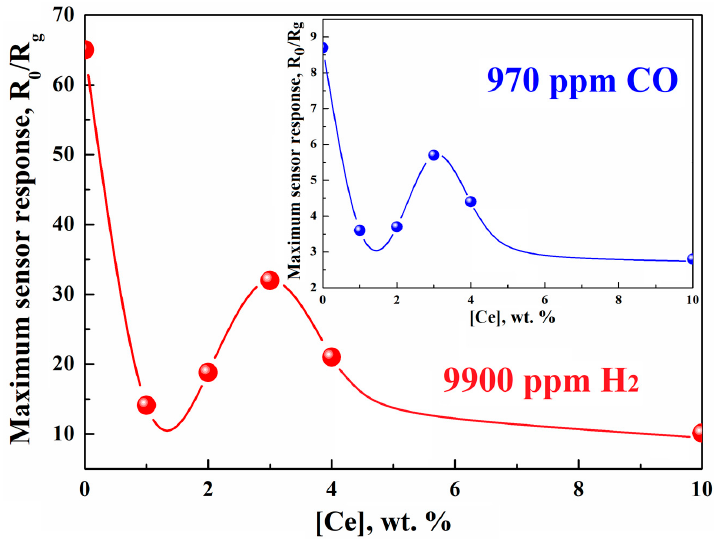
Figure 7. Concentration dependence of the maximum sensor response of the CeO 2 –In 2 O 3 composites upon detection of 9900 ppm H 2 (970 ppm CO in the inset).